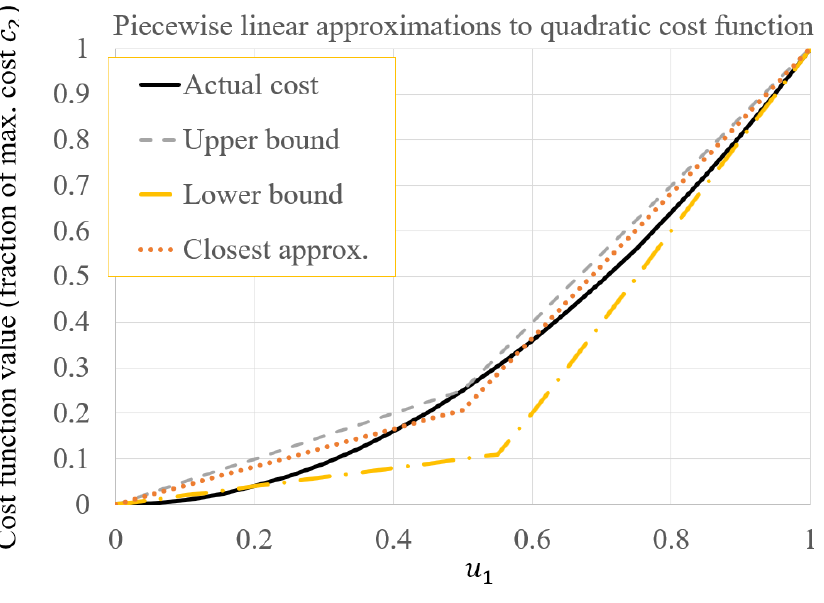
Figure 1. Approximation of the quadratic cost function with piecewise linear functions. The linear functions shown give upper and lower bounds to the quadratic cost function, as well as a best approximation that minimizes the maximum deviation between the quadratic cost function and piecewise linear